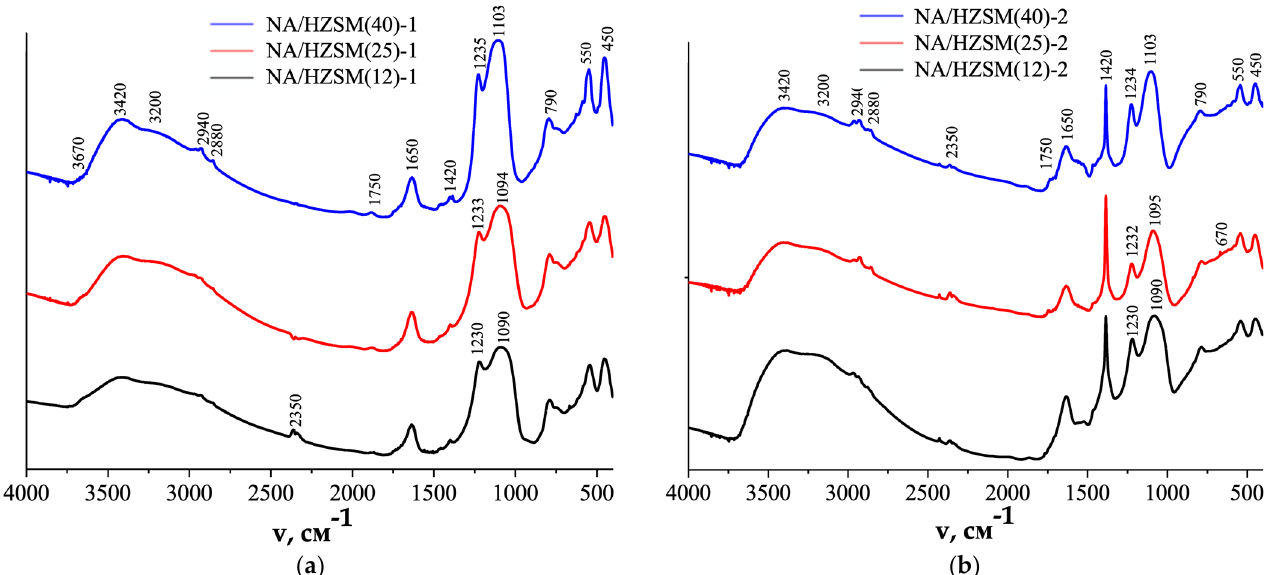
Figure 7. FTIR spectra of NA/HZSM-1 ( a ) and NA/HZSM-2 ( b ) in coordinates Intensity (arbitrary units, a.u.)—absorption frequency (v, cm − 1 ) (adapted from [16]).